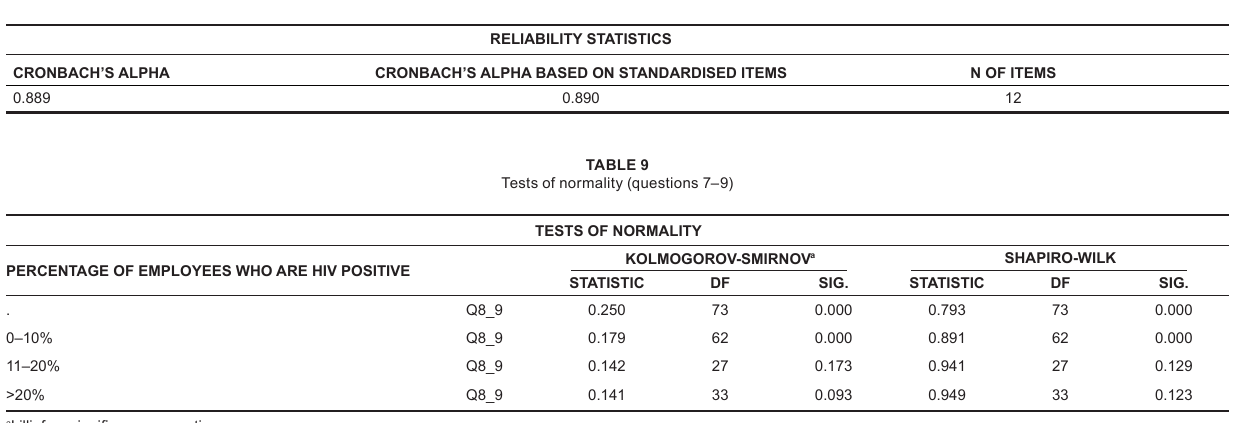
TABLE 8 Reliability statistics (on the combination of questions